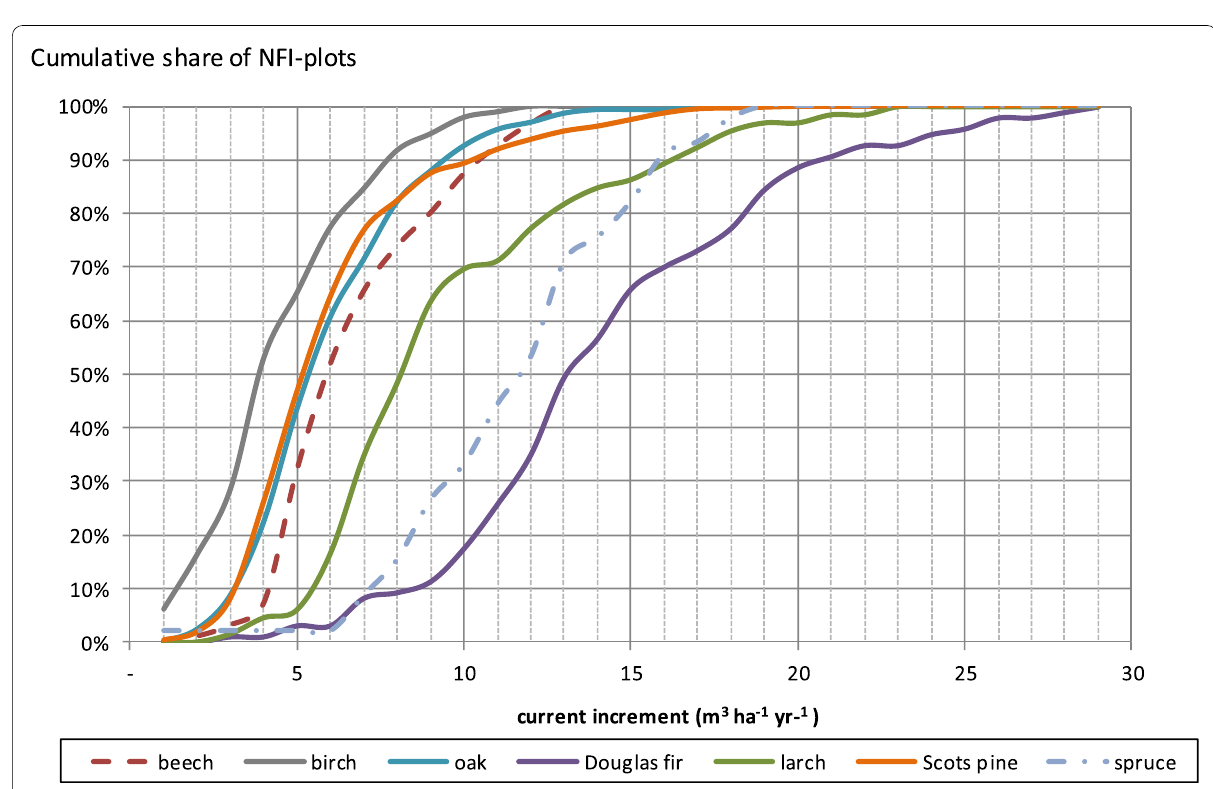
Fig. 4 Cumulative share of plots in the nationalforest inventory with a given current growth (in m 3 ha -1 year -1 )for the distinguished seven tree species, i.e. beech, birch, common oak,Douglas fir, Japanese larch, Scots pine and Norway spruce (After Schelhaas etal.,